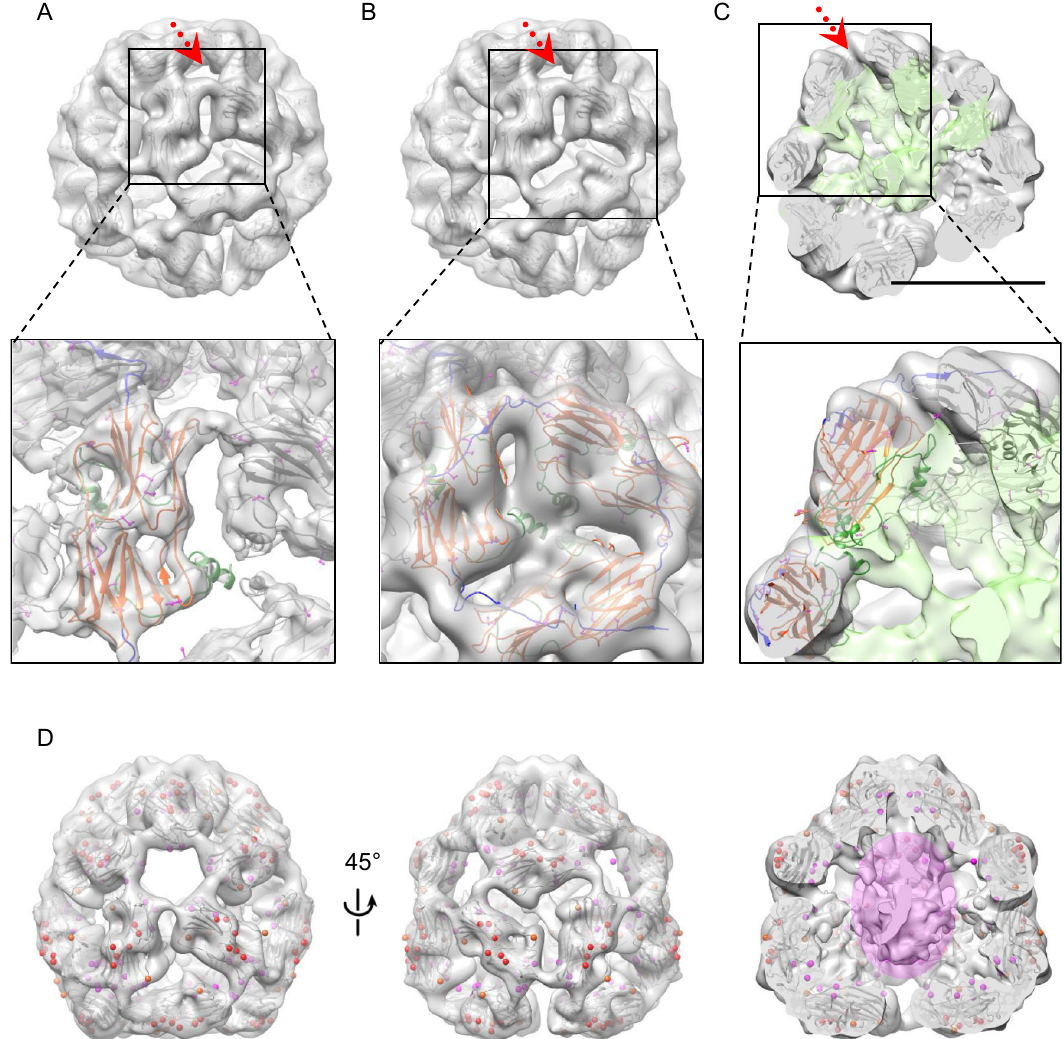
Fig. 4 Structure of the atomic model. Each view contains an overview image with a zoomed inset of the highlighted area. The top row overview images contain the WT EM density surface maps with the wheat Hsp16.9 crystal structure (1GME) fi tted in. The enlarged area images in the bottom row contain our pseudo-atomic model. A Focusing on one dimer in the 40mer environment. The surface model is based on the sharpened partial reconstruction of only the two top rings thresholded to better visualize the loops and the IEV-binding site (GSFSC resolution 6.1 Å). The pseudo-atomic model in the enlarged view at the bottom is color-coded as follows: All potential phosphorylation sites are colored magenta in the ball and stick representation. The ribbon of the central dimer is colored according to the color scheme in Fig. 1A. Thus, the MD is dark green, the ACD orange-red, and the CTR is blue. All other ribbons are colored gray. B Focus on one hexamer. Threshold of the surface map rendering was lowered to include the MD and NTS density. Color code as in A . The ribbons of all protein chains comprising one hexamer are colored as the central dimer in A , while the ribbons of other dimers are colored in gray. C Focus on the connectivities of one hexamer and the central core of the structure. The frontal density has been removed to reveal the inner structure. The threshold of the surface map rendering was lowered to include the MD and NTS density as in B . The blue C-terminal regions connect dimers at the outside of the oligomer, whereas the MD connects the dimers on the inside. Color-coding was performed as in A and the ribbon of the same hexamer is colored as in B. The volume containing middle domain and N-terminus has been highlighted in mint. Scale bar 10 nm. D WT 40mer reconstruction with all phosphorylation sites labeled with spheres that are part of the pseudo-atomic model. The sphere is centered around the C β atom of the respective residue. For clarity, the C-terminal phosphorylation sites are labeled red and the S144 in orange. The other two sites located toward the inside of the structure are labeled magenta. In the third image, the structure is cut open to show the inside that has been highlighted magenta to roughly indicate the volume encompassing over 60 phosphorylation